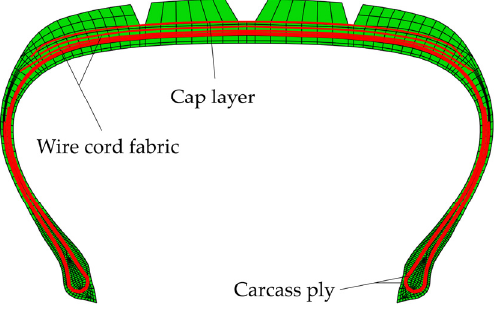
Figure 3. Reinforcing layer structure of tires.